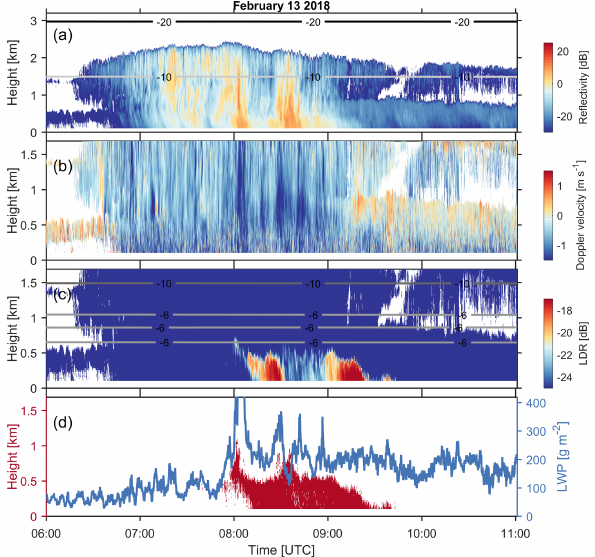
Figure 9. Same as Fig. 8 but for the columnar-ice-producing event observed on 2 February 2018. A zoom-in view on the wave signa- tures between 05:30 and 07:00UTC is presented in (b)